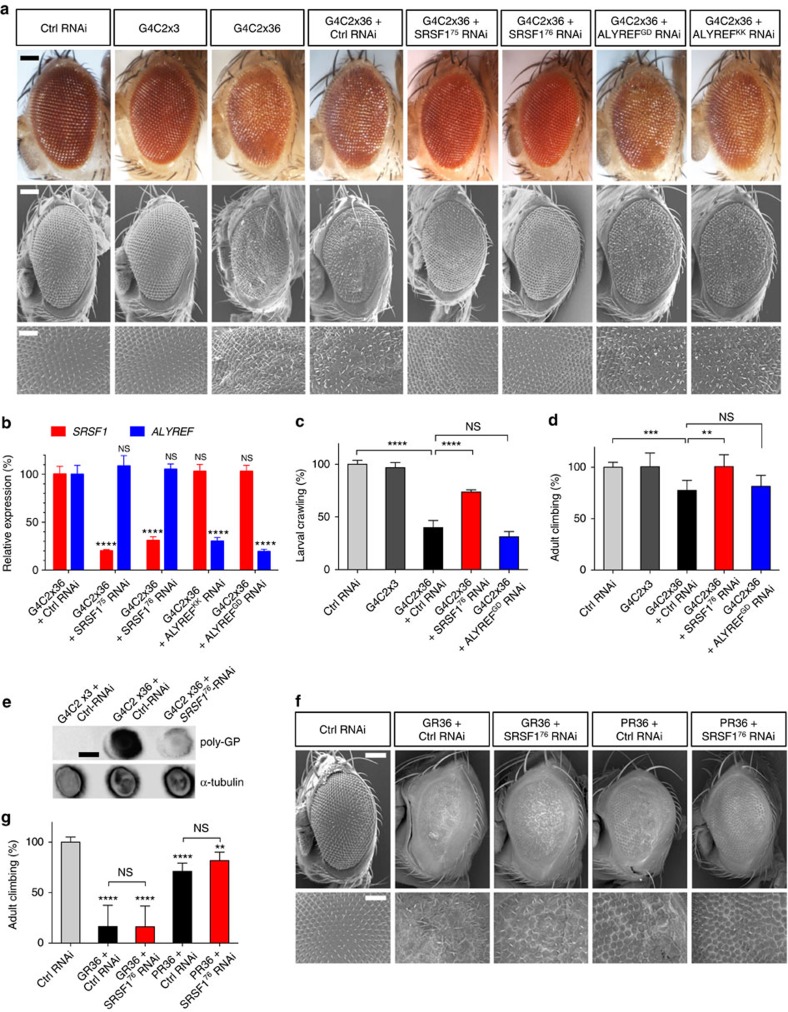
Depletion of SRSF1 prevents in vivo neurodegeneration and restores locomotor function.(a) Representative light and scanning electron micrographs show normal eye phenotypes for Control (GAL4/luciferase-RNAi) and G4C2x3 flies. Expression of G4C2x36 causes a rough eye phenotype which is fully rescued by SRSF1 knockdown. Scale bars: 100 μm for low magnification and 50 μm for zoomed micrographs. (b) SRSF1 (red) and ALYREF (blue) transcript levels were quantified by qRT–PCR analysis in independent knockdown lines in G4C2x36 flies. Tub84b transcript levels were used for normalization in three biological replicate experiments (mean±s.e.m.; two-way ANOVA with Tukey’s correction for multiple comparisons; N (qRT–PCR reactions)=6). (c,d) Neuronal expression of G4C2x36 causes larval crawling (c) and adult climbing (d) deficits that are both restored by SRSF1 depletion (mean±95% CI normalized to control; Kruskal–Wallis non-parametric test with Dunn’s correction for multiple comparisons; N (larvae)=10; N (adults)=control (GAL4/luciferase-RNAi): 93, G4C2x3: 26, G4C2x36+Ctrl-RNAi: 62, G4C2x36+SRSF1-RNAi: 50, G4C2x36+ALYREF-RNAi: 36). (e) Total protein extracts from G4C2x3+Ctrl-RNAi, G4C2x36+Ctrl RNAi and G4C2x36+SRSF1-RNAi Drosophila larvae were analysed by dot blots using poly-GP and loading control α-tubulin antibodies. Scale bar, 6 mm. (f) SRSF1 depletion in Drosophila models expressing DPRs independently of G4C2 repeat expansions and RAN translation16. (g) Neuronal expression of poly-Gly-Arg DPRs (GR36) and poly-Pro-Arg DPRs (PR36) causes adult climbing deficits that are not restored by SRSF1 depletion (mean±95% CI normalized to Control; Kruskal–Wallis non-parametric test with Dunn’s correction for multiple comparisons; N=Control (GAL4/luciferase-RNAi): 239, GR36+Ctrl-RNAi: 12, GR36+SRSF1-RNAi: 7, PR36+Ctrl-RNAi: 125, PR36+SRSF1-RNAi: 119). Statistical significance of data is indicated as follows: NS: non-significant, P≥0.05; *P<0.05; **P<0.01; ***P<0.001; ****P<0.0001.